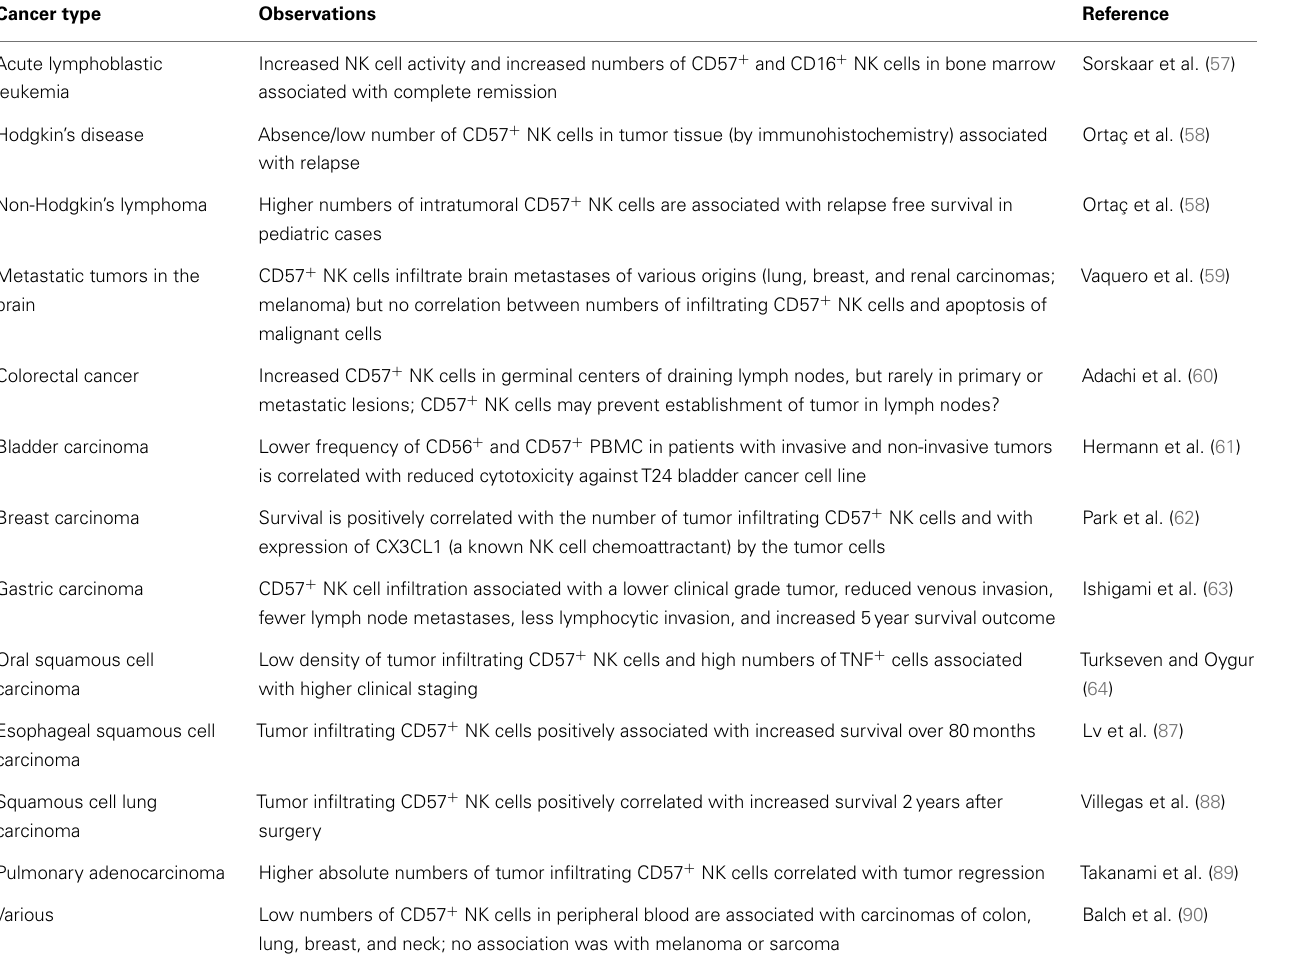
Table 1 |Associations between cancer prognosis and CD57 expression by NK